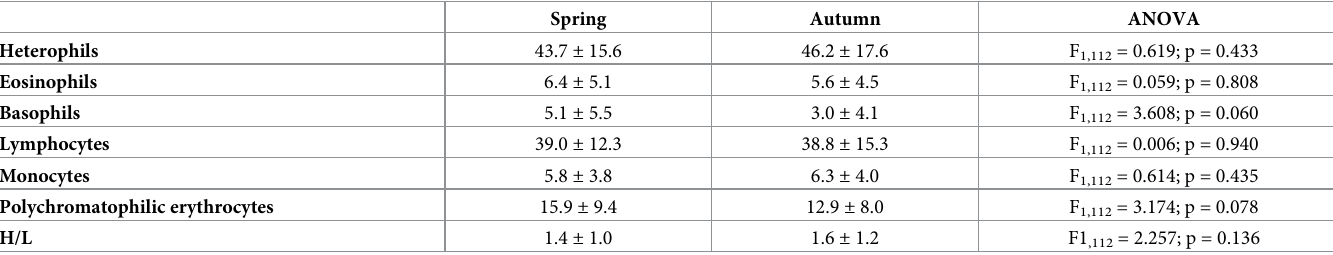
Table 5. Comparison of leucocyte profiles (mean ± SD) of dunlins between spring and autumn